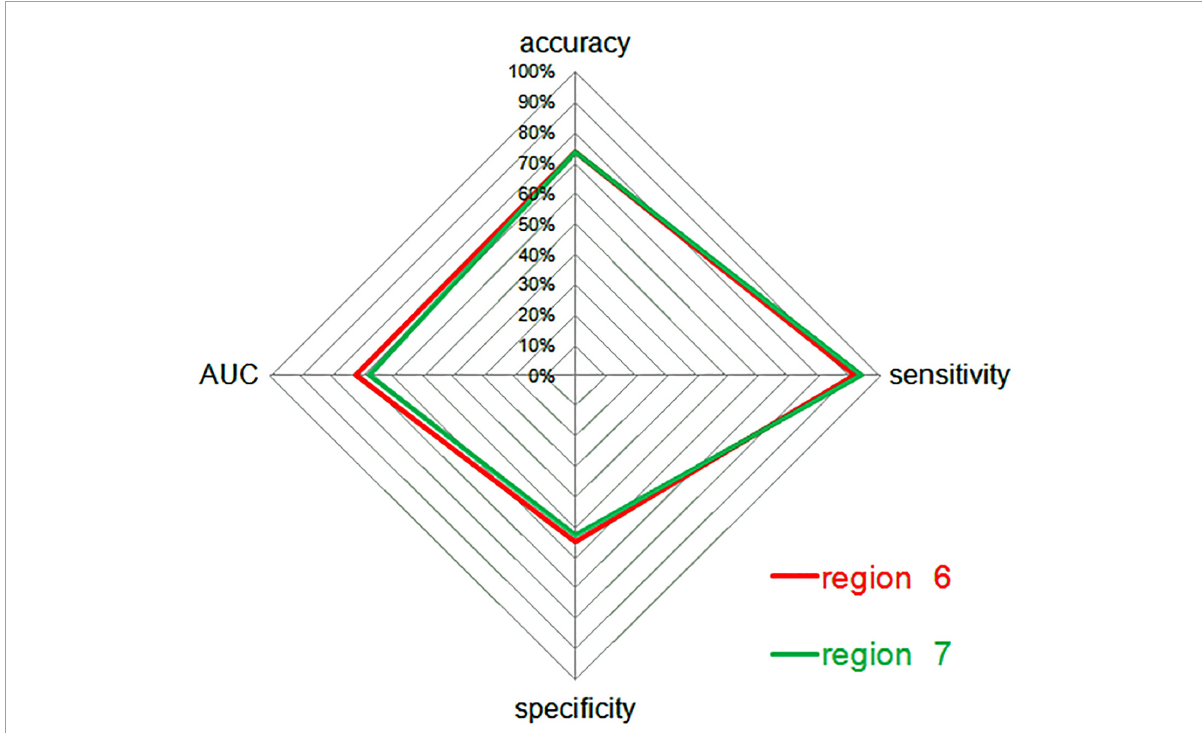
FIGURE5 A radar plot demonstrating the accuracy, sensitivity, and specificity of classifications for SCH patients and HCs between region 6 and region 7, with corresponding AUC values. AUC, area under the curve; SCH, schizophrenia; HCs, healthy controls; 6, bilateral precuneus; 7, left angular gyrus.